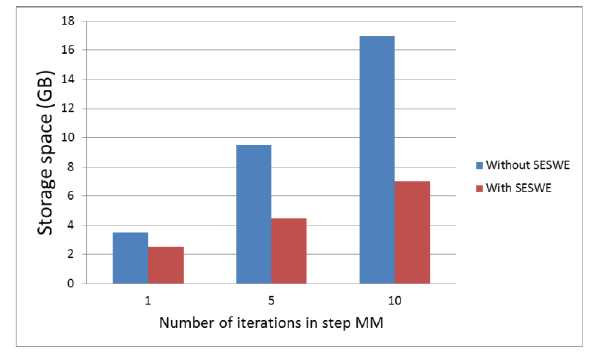
The same test method is applied on WB, three work- flows with different iterations in step MM are tested. The runtime of each workflow is shown in Figure